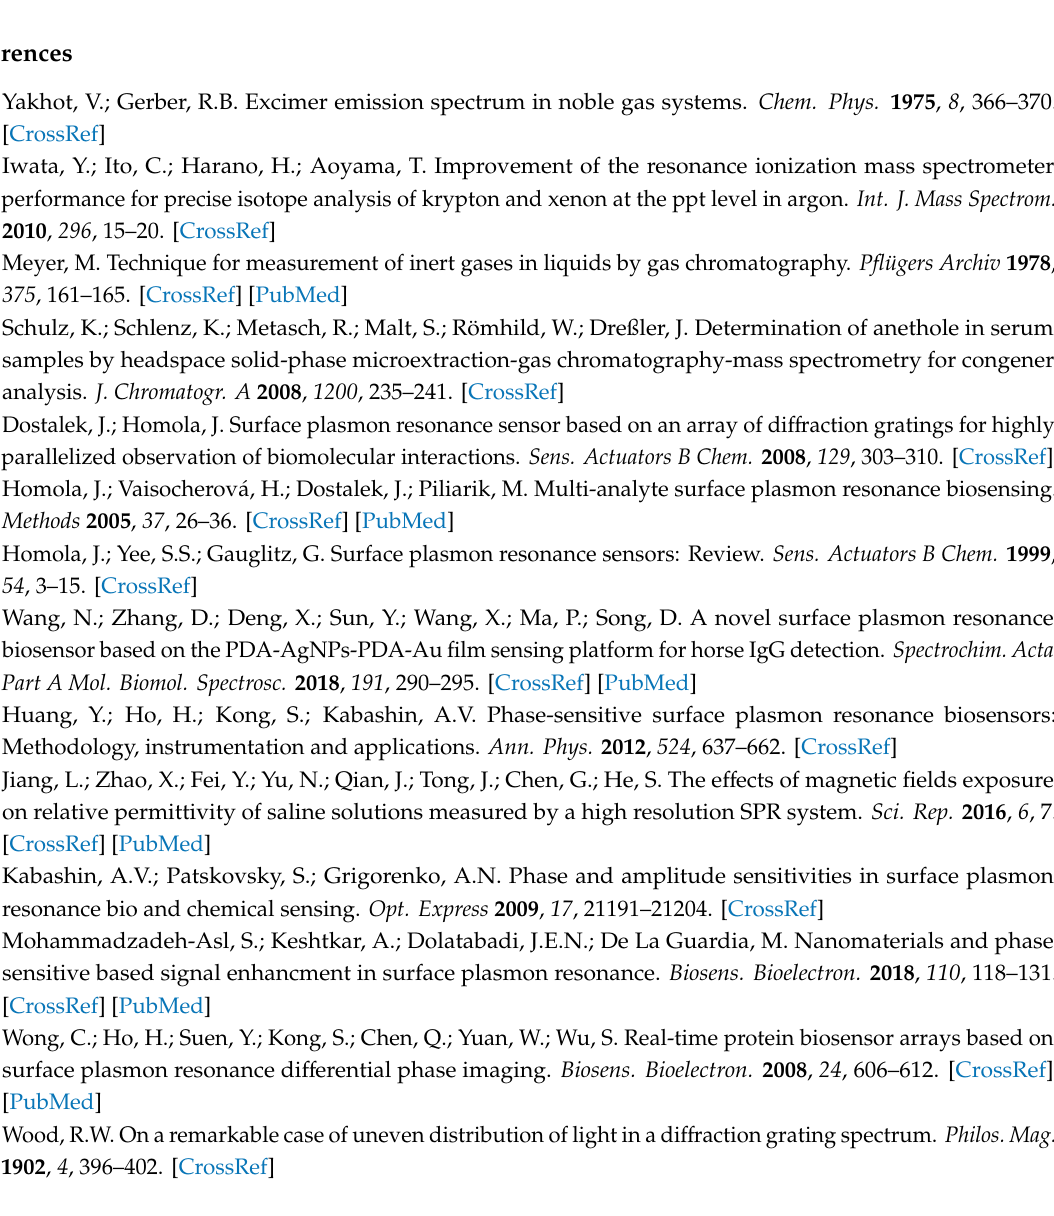
Figure S1: The presentation of the standard error; Figure S2: A set of gray images with di ff erent gas mixture